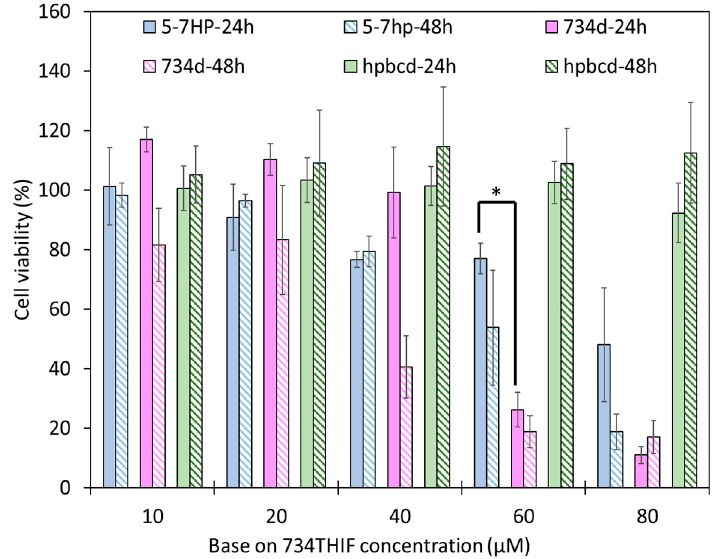
Figure 8. The HaCaT cell viability of 734THIF, 5-7HP and HP β CD at 24 and 48 h. All columns are mean ± SD ( n = 3); * p < 0.05. HP β CD concentration was calculated by 5-7HP, which means it needs to be multiplied by 5; for example, 10 μ M represent 50 μ M HP β CD and so on.